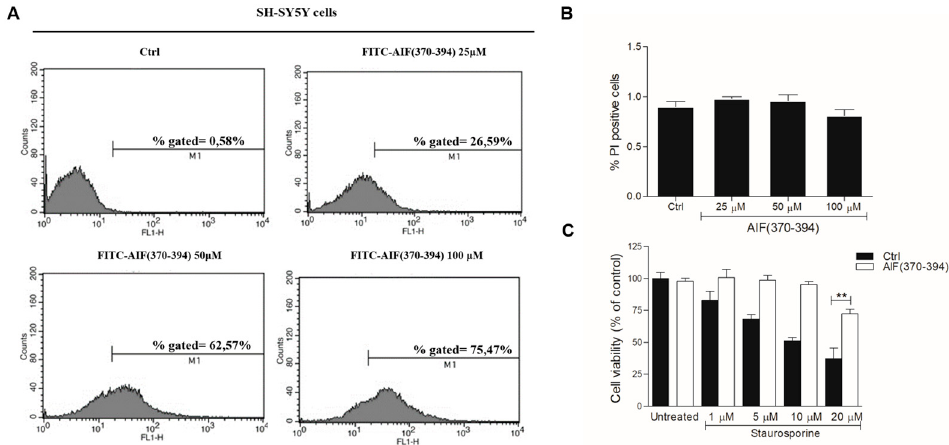
Figure 3. Transfection of the peptide AIF(370-394) protects SH-SY5Y cells from death induced by STS. ( A ) Assessment of AIF(370-394) transfection efficiency after 24 h using flow cytometry and the FITC-conjugated TAT peptide at 25, 50, and 100 µM. ( B ) Evaluation of the cytotoxic effects of FITC-AIF(370-394) by FACS analysis; apoptotic cells were stained with PI. ( C ) MTT viability assay of SH-SY5Y cells transfected with AIF(370-394) exposed to STS for 3 h at the indicated concentrations, (n = 8, ** p < 0.01).